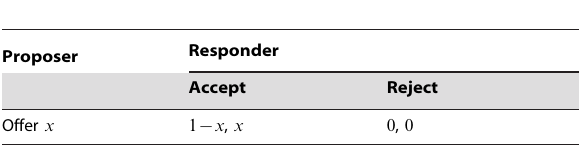
Table 2. The Ultimatum